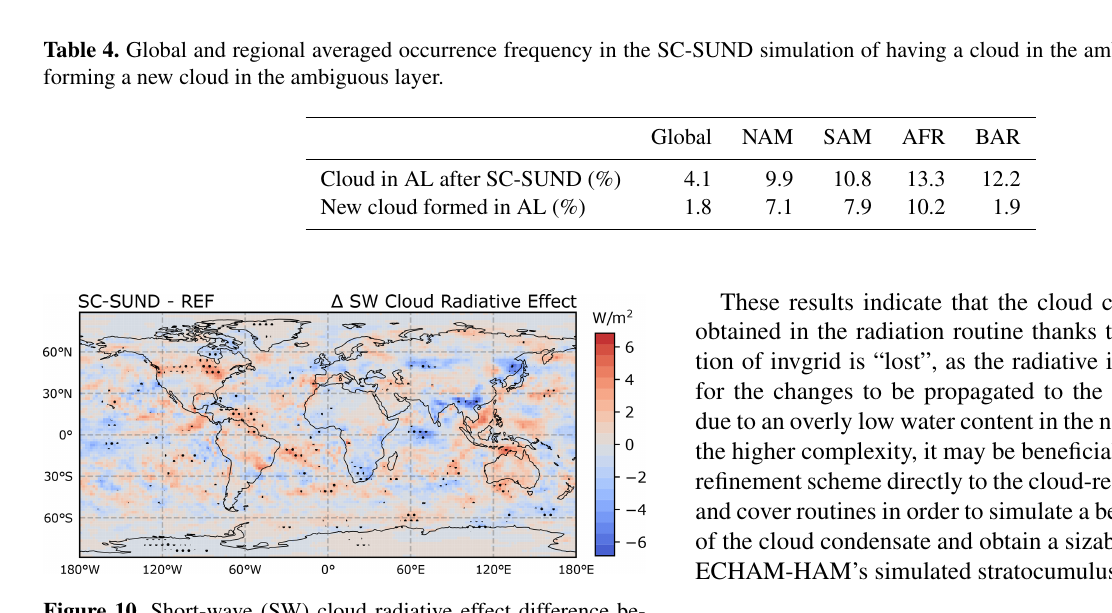
Figure 10. Short-wave (SW) cloud radiative effect difference be- tween the REF and SC-SUND simulations. Stippling indicates sta- tistically significant differences at the 95% significance level; the false discovery rate is controlled following Wilks